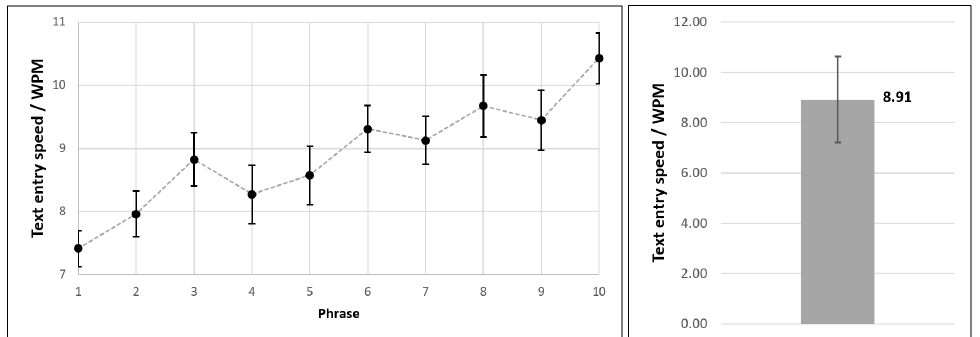
Figure 11. Text entry speed obtained within the empirical evaluation of magnet-based text en- try